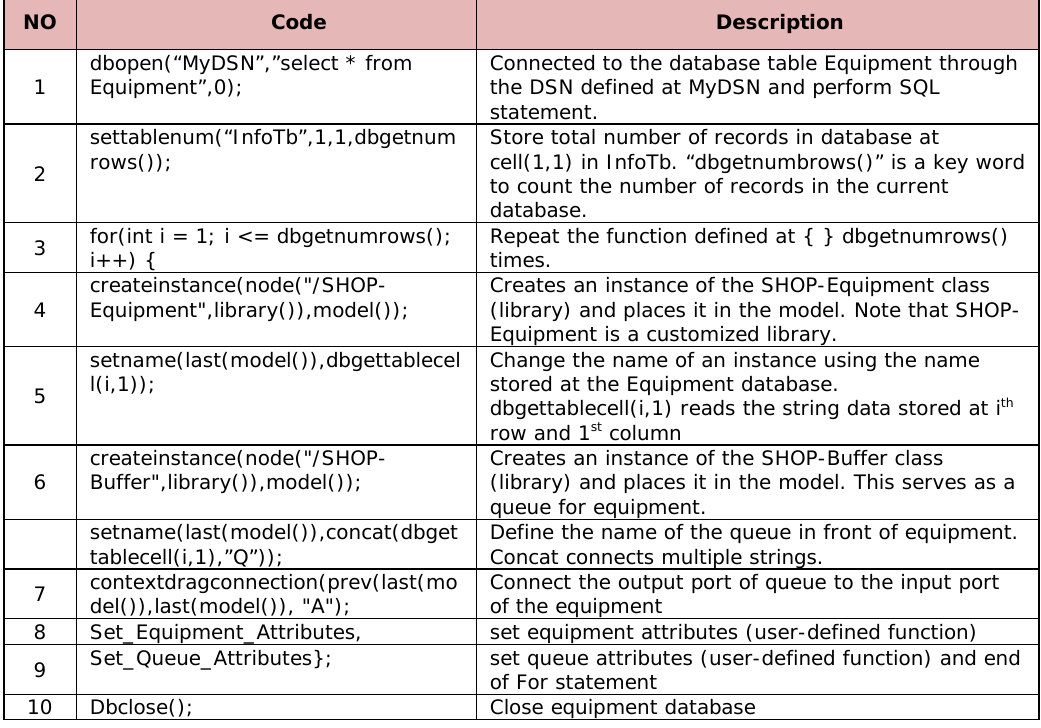
Table 3. “Partial pseudo code in simulation model